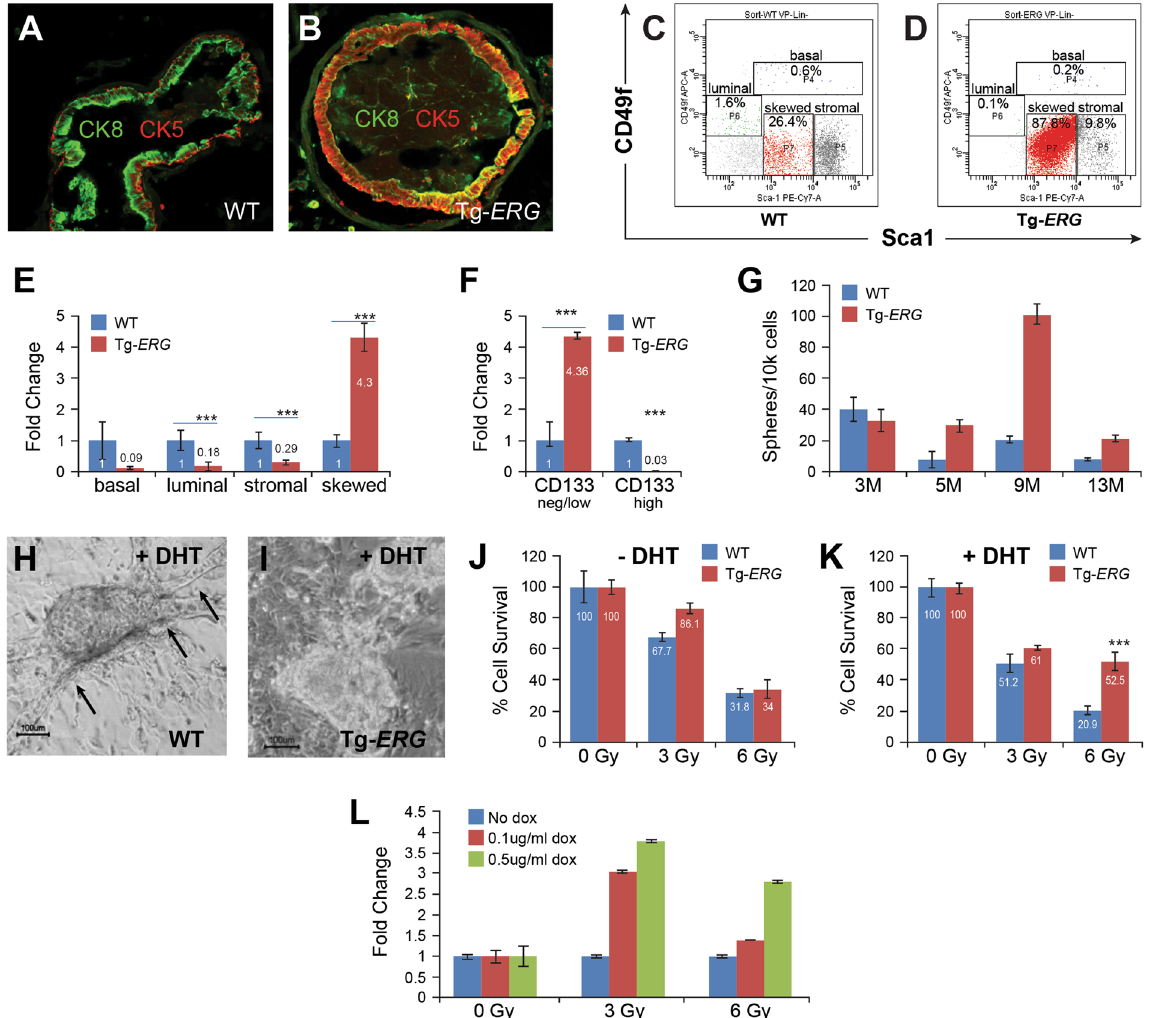
Figure 8. ERG alters molecular and morphological characteristics of luminal epithelial cells. Expression of Ck5 (basal) and Ck8 (luminal) cell markers in wild-type and Tg- ERG mouse prostates was performed by immuno- fluorescence on frozen sections. Wild-type mouse prostate glands express Ck5 (red) and Ck8 (green) ( A ). Tg- ERG prostate glands express increased number of cells double positive for both Ck5 and Ck8 ( B ). FACS analysis of isolated luminal cells from wild-type ( C ) and Tg- ERG mice ( D ) showed a significant increase in CD49f (low) and Sca-1 (med) in Tg- ERG mice. Normalized fold induction/reduction in frequencies of basal, luminal, stromal, skewed populations show about 4-fold increase of skewed population in Tg- ERG prostates ( E ). The frequencies of CD133 expression in percentages within skewed (red), stromal (grey) populations in wild-type and Tg- ERG mice show increase in CD133 negative/low and decrease in CD133 high cells in Tg- ERG prostates ( F ). Quantitative analysis of sphere forming units ( G ) from ventral prostates of wild-type and Tg- ERG mice shows the number of spheres grown per 10 4 input cells. The number of sphere forming units (SFU)/10,000 cells in the Tg- ERG was approximately 1–5 fold compared to controls (n = 6). Prostate epithelial cells isolated from wild-type ( j,k ) and Tg- ERG mouse ( H,I ) prostates develop spheres in semi-solid Matrigel. Spheres grown in the presence of 10 nM DHT on matrigel coated plates developed duct like structures ( H ). Duct like structures was not observed in spheres developed from Tg-ERG in the presence of DHT ( I ). Both wild-type and Tg- ERG prostate spheres grown on matrigel in the absence of DHT showed only about 31.8–34% cell survival upon 6 Gy radiation ( J ). Spheres developed from Tg- ERG in the presence of DHT showed 52.5% cell survival compared to 20.9% of wild-type derived spheres ( K ). Similarly, LNCaP-LnTE3 cells grown in the presence of 0 to 0.5 ug/ml of doxycycline to induce ERG displayed relatively 2.75 to 3.75 folds enhanced survival compared to controls with 3 and 6Gy radiation ( L